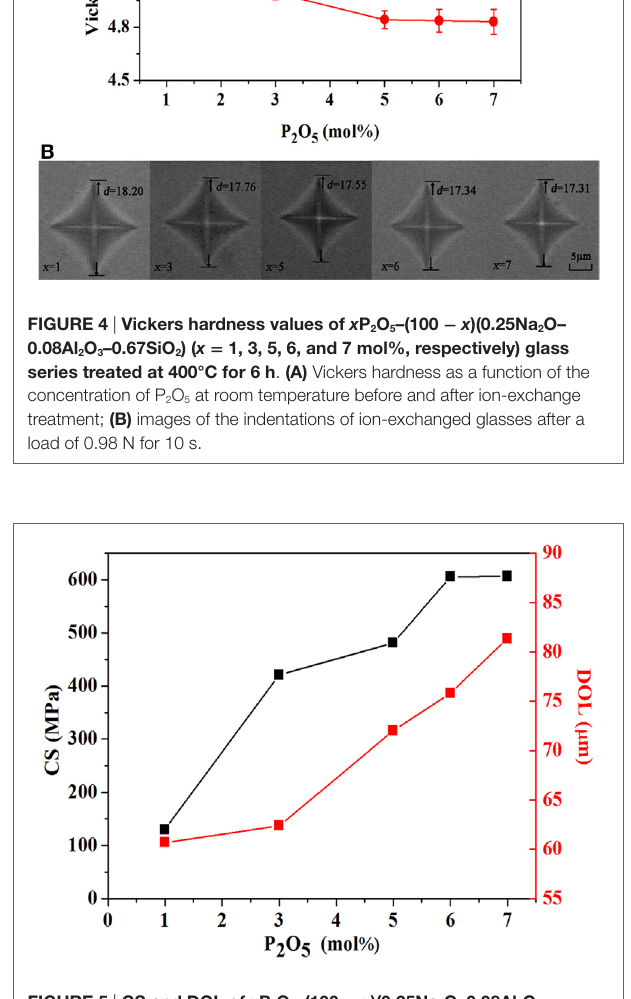
FigUre 5 | cs and DOl of x P 2 O 5 –(100 − x )(0.25na 2 O–0.08al 2 O 3 – 0.67siO 2 ) ( x = 1, 3, 5, 6, and 7 mol%, respectively) chemically strengthened glasses treated at 400°c for 6 h .